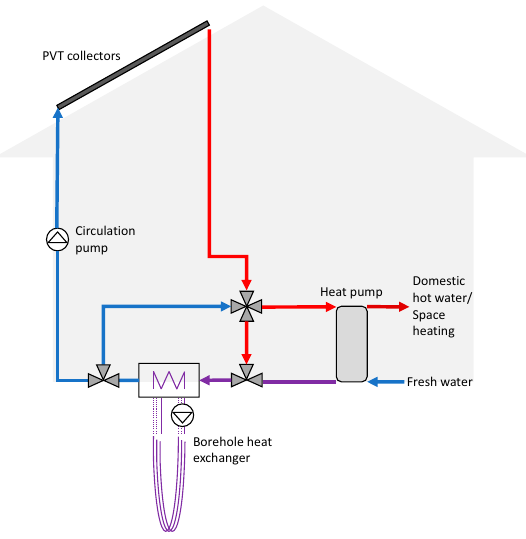
Figure 5. Energy system under investigation—Installation of PVT collectors, a brine-to-water heat pump and a borehole heat exchanger for the provision of a constant brine temperature. The circulating pump is actively operated by the two control approaches studied here.